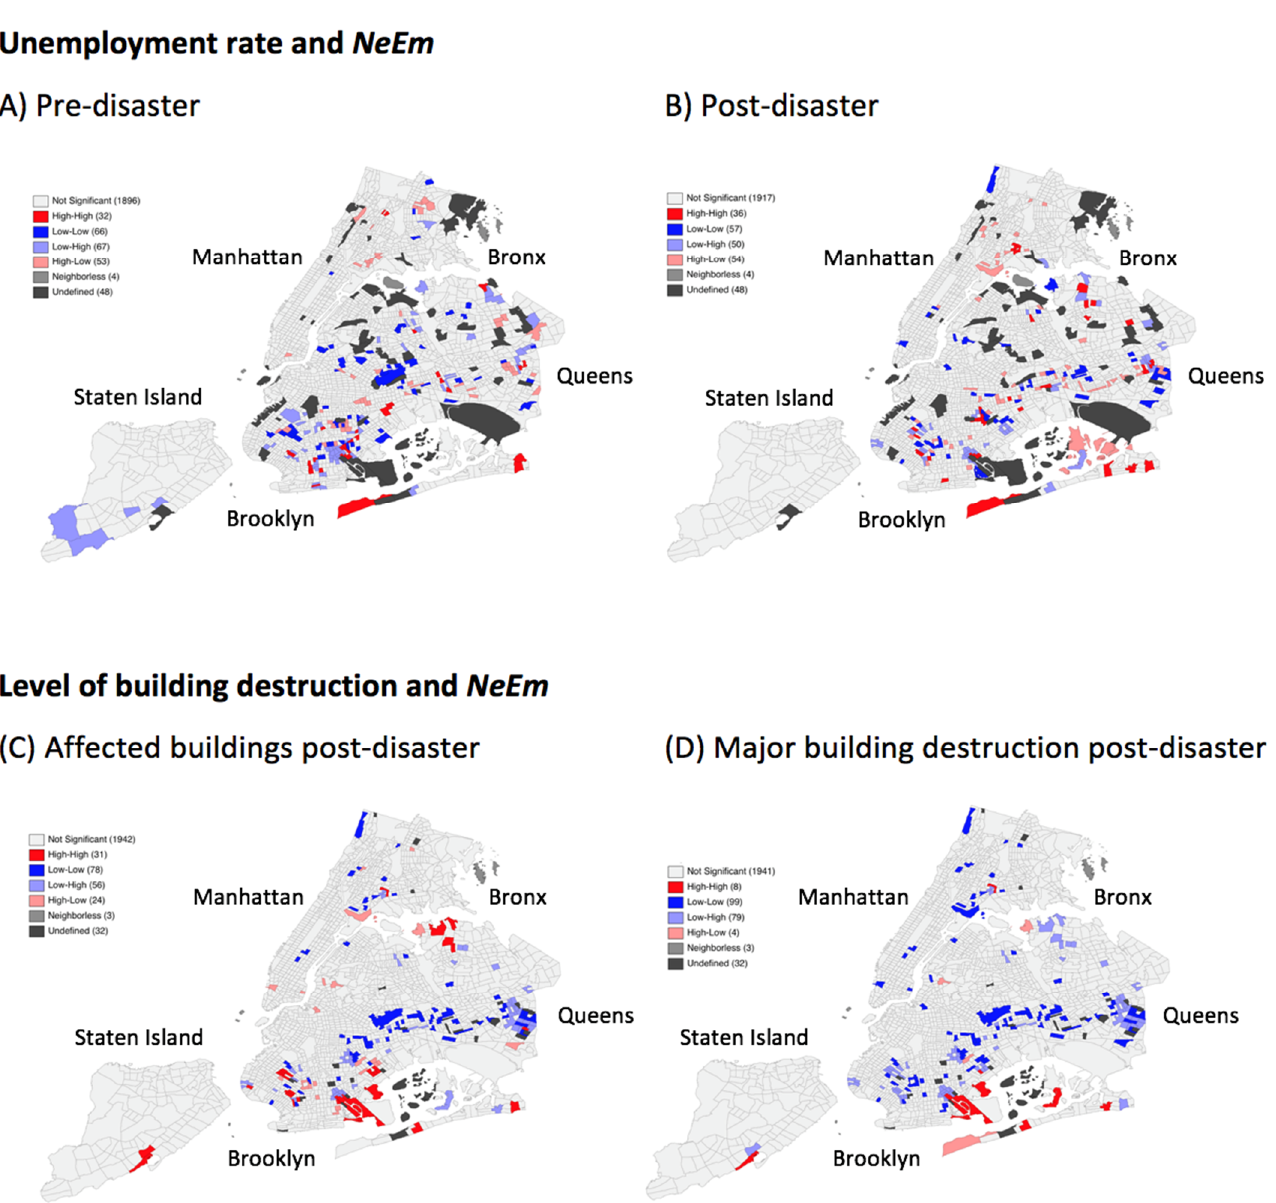
Figure 3. Bivariate spatial clusters exhibiting local spatial associations between exposure factors unemployment rate ( A , B ) and levels of building destruction ( C , D ) with the combined set of negative emotions (NeEm) across disaster periods.